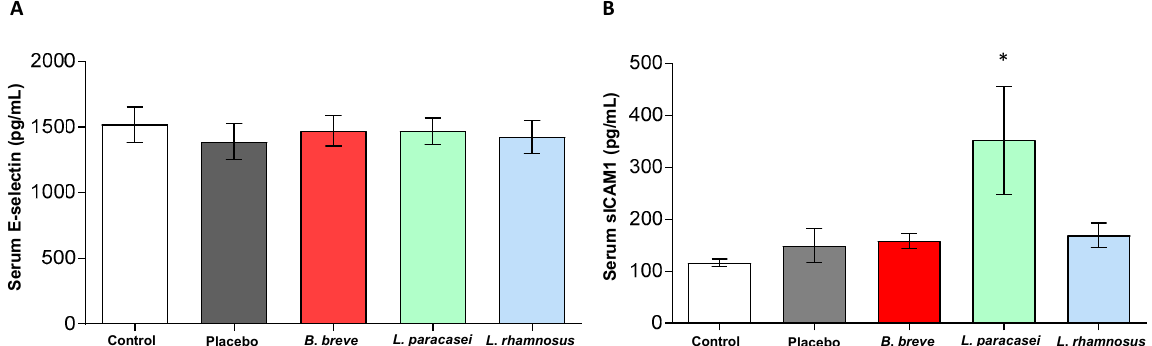
Figure 2. Serum concentration of ( A ) E-Selectin and ( B ) sICAM1 of rats fed either placebo, B. breve CNCM I-4035, L. paracasei CNCM I-4034 or L. rhamnosus CNCM I-4036 for 30 days. Values are the means ± SEM. n = 8 per group. * p < 0.05 vs. placebo. B, Bifidobacterium ; L, Lactobacillus ; sICAM1: soluble intercellular adhesion molecule-1.